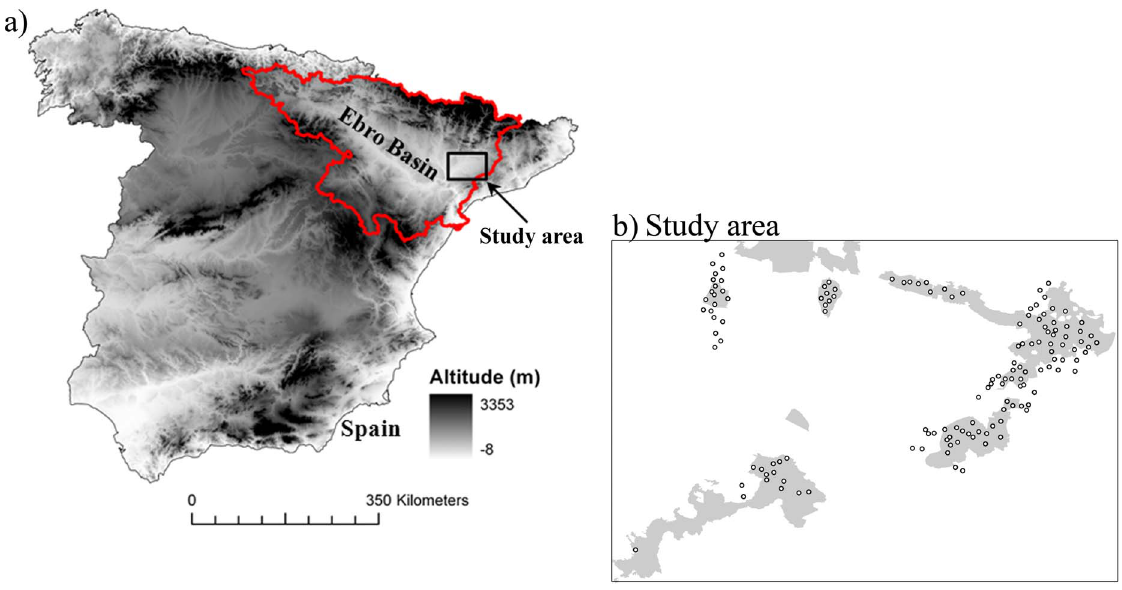
Figure 1. Study area. (a) Location of the study area and (b) distribution of monitored transects (represented by dots) during years 2010–2011 in the study area. In grey, areas included in the Natura 2000 network.